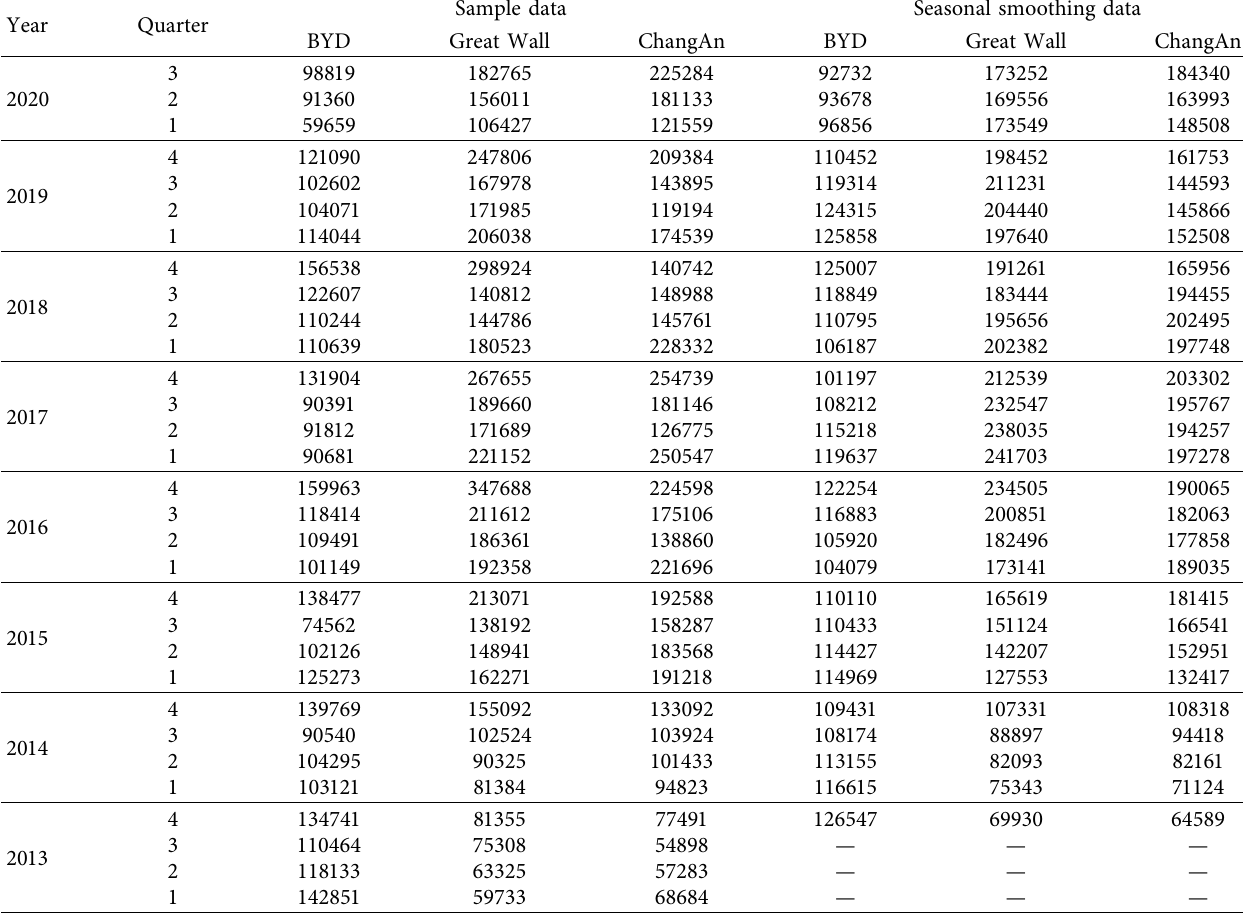
Table 3: Sample data and seasonal smoothing data of car sales.